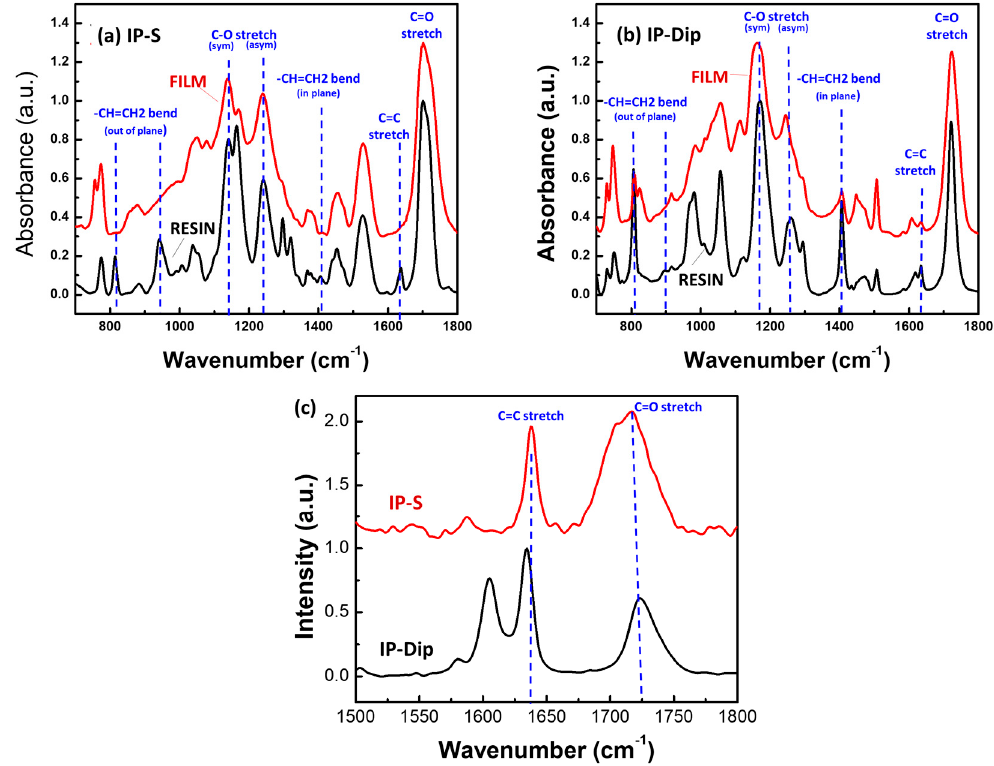
Figure 7 . Fourier transform infrared ( FTIR) spectra of the resin and fully cured film of ( a ) IP-S and ( b ) IP-Dip over the fingerprint region of 700–1800 cm − 1 . The bands associated with the terminal CH 2 =CH- stretching and bending modes are indicated on the spectra. ( c ) Raman spectra of IP-Dip and IP-S 2PP cured photoresists.